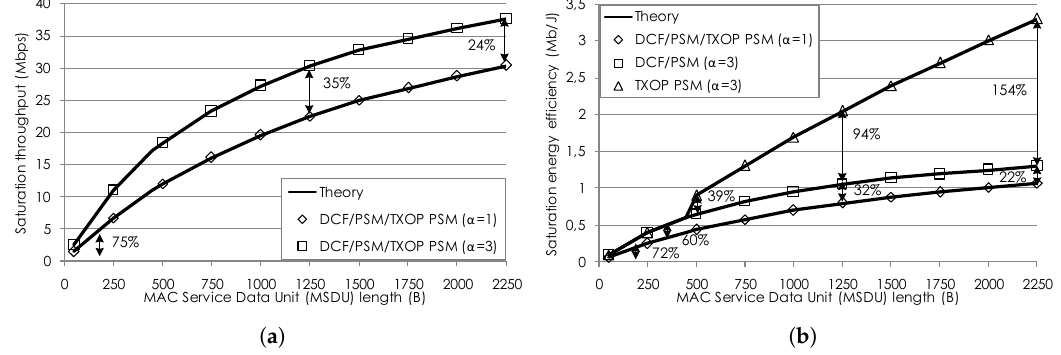
Figure 3. Saturation throughput and energy efficiency of the evaluated mechanisms with α = 1 and α = 3 rounds of data transmissions as a function of the MSDU length. ( a ) Saturation throughput. ( b ) Saturation energy